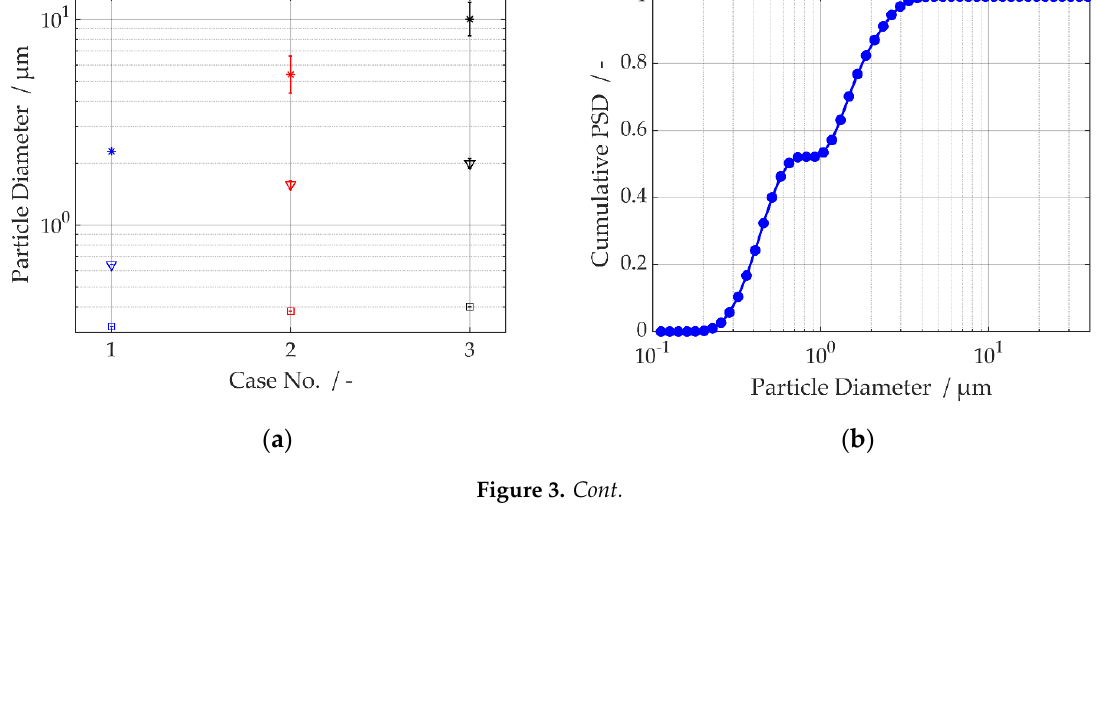
Figure 2. Particles in the feed dispersion. ( a ) Particle Size Distributions of LFP (grey) and Carbon Black (black) particles. ( b ) SEM image of LFP and Carbon Black particles on a nucleopore